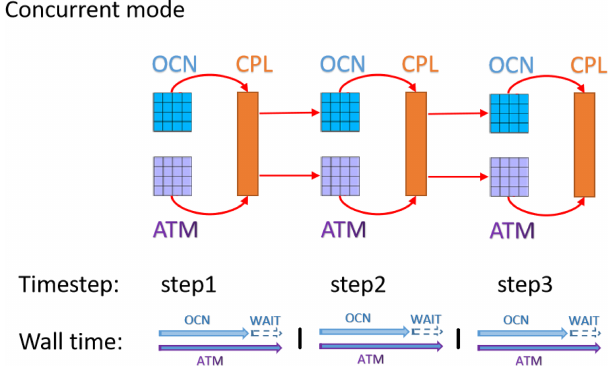
Figure 2. Concurrent mode of the coupled model. The small blocks under OCN or above ATM are the small subdomains in each node; the block under CPL is the coupler. The red curve arrows indicate that the component models are sending data to the coupler and the red straight arrows indicate that the component models are reading data from the coupler. The horizontal arrows in the wall time indi- cate the time axis of each component model and the ticks on the time axis indicate the coupling time